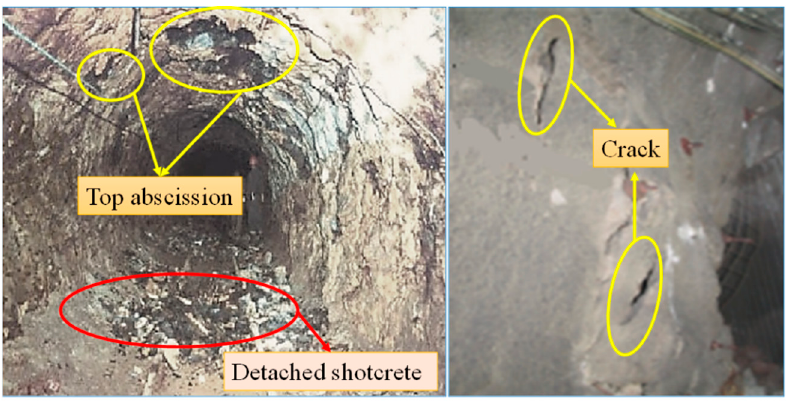
Figure 3. Shotcrete layer falling off at high temperature.